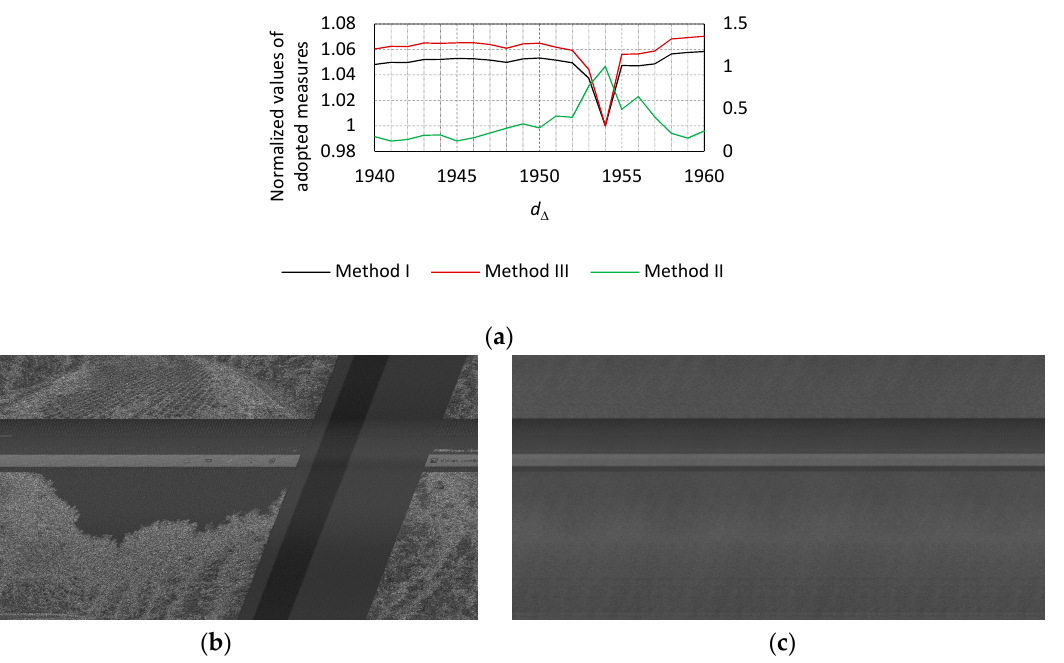
Figure 12. ( a ) The normalized values of the adopted measures (method I, II and III) calculated in domain of image line length d ∆ for the accuracy ∆ = 1.0 (for the original image shown in Figure 7a) and images reconstructed on the basis of the recorded revealing emission signals at frequency f o = 1334 MHz (receiving bandwidth BW = 50 MHz, accuracy ∆ = 1.0), ( b ) for estimated line length 𝑑 ∆ = 1954.00000 , multiple of image summation 𝑆𝑢𝑚 (cid:3014)(cid:3021)(cid:3013) = 1 and ( c ) for estimated line length 𝑑 ∆ = 1954.00000 , image summation multiple 𝑆𝑢𝑚 (cid:3014)(cid:3021)(cid:3013) = 30 —the source of revealing signal emission—display monitor, HDMI standard.